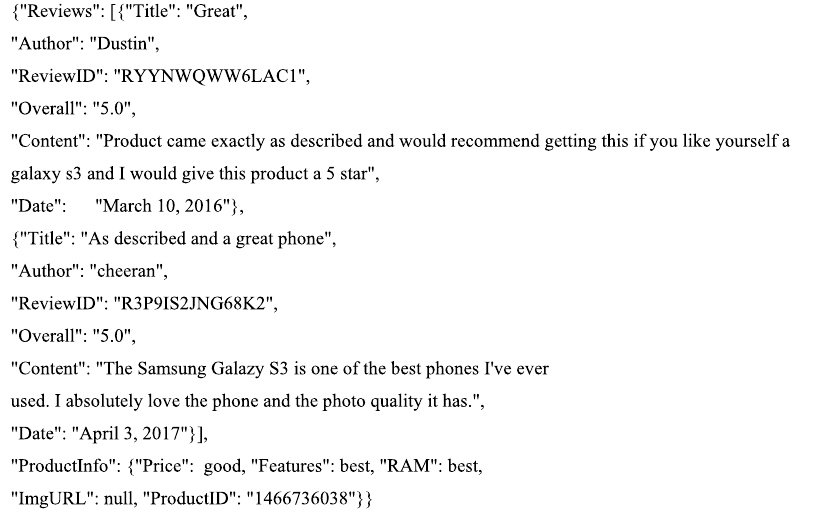
Table 1 Sample set of Product